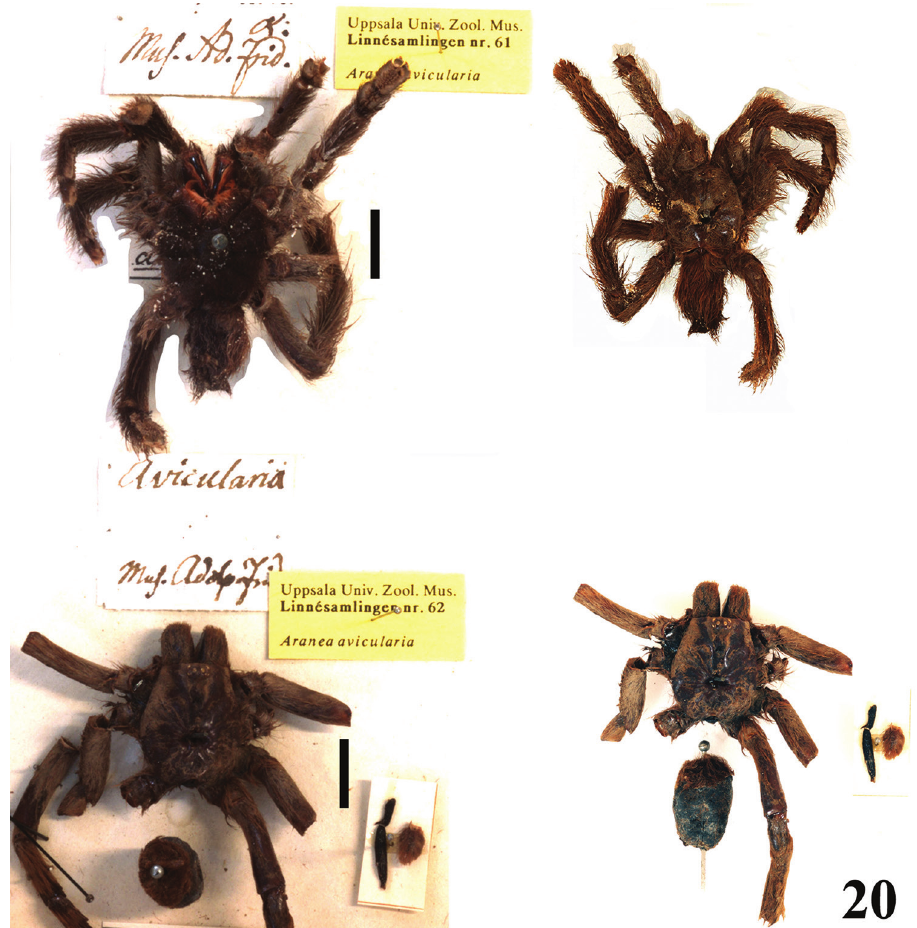
Figure 20. Avicularia avicularia (Linnaeus, 1758), types from Uppsala Collection (UUZM). Above, lectotype female (UUZM 61), below paralectotype (UUZM 62). Photo: Mats Eriksson, published with UUZM